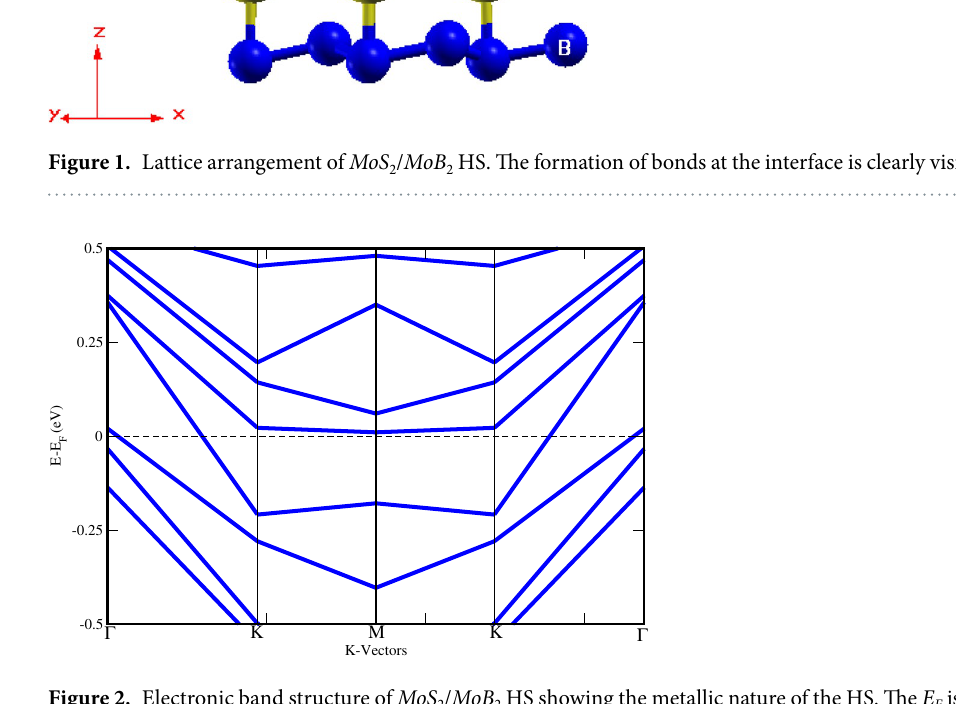
Figure 2. Electronic band structure of MoS 2 / MoB 2 HS showing the metallic nature of the HS. The E F is set to zero reference